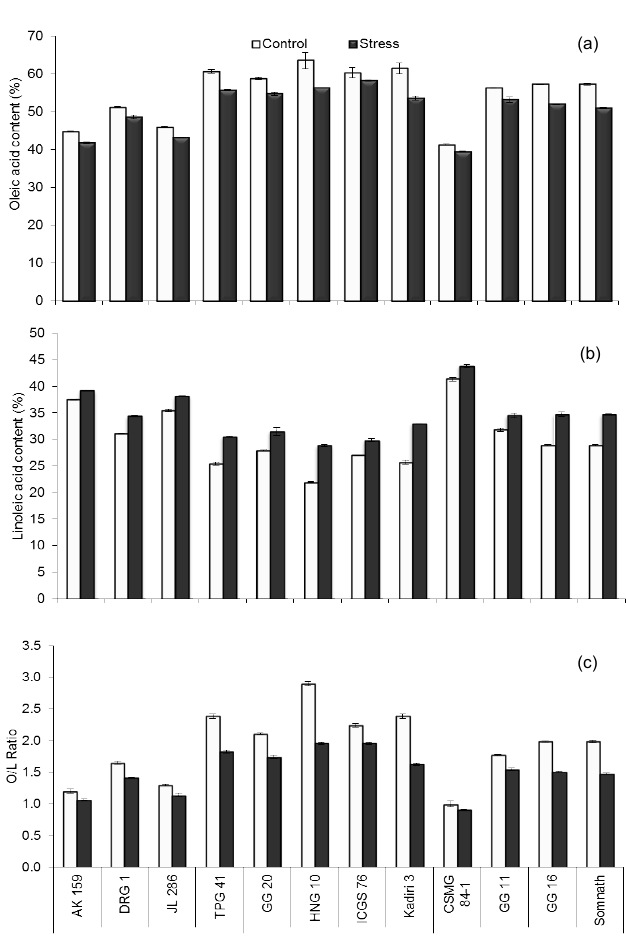
Fig. 3: Changes in Oleic (a), Linoleic (b) acid content and O/L ratio (c) in groundnut cultivars under water deficit